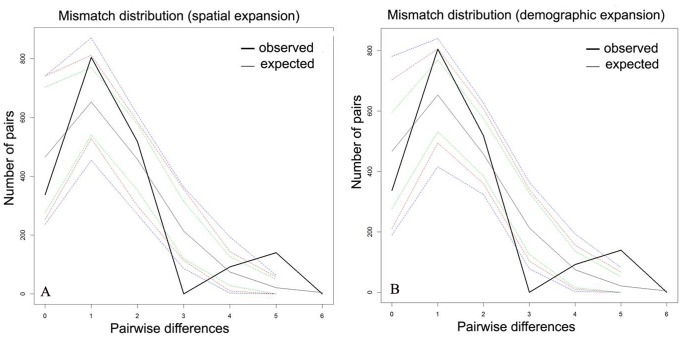
Mismatch distribution of expected and observed with confidence intervals (A: spatial expansion; B: demographic expansion) of A. ardens.On the horizontal axis is the number of nucleotide site differences between pairs of individuals.